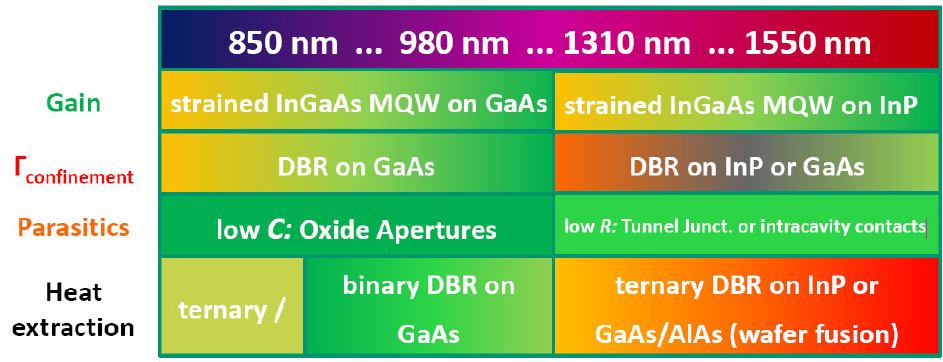
Figure 1. Present device technologies for the 850–1550 nm wavelength window [27]. For longer wavelengths, GaSb-based material structures are considered.